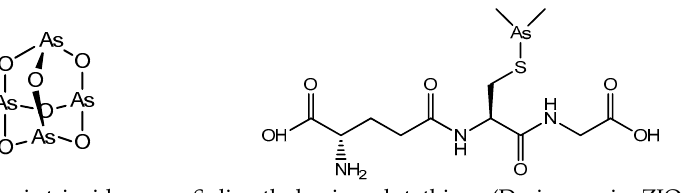
Figure 3. Chemical structure of arsenic anticancer drugs.